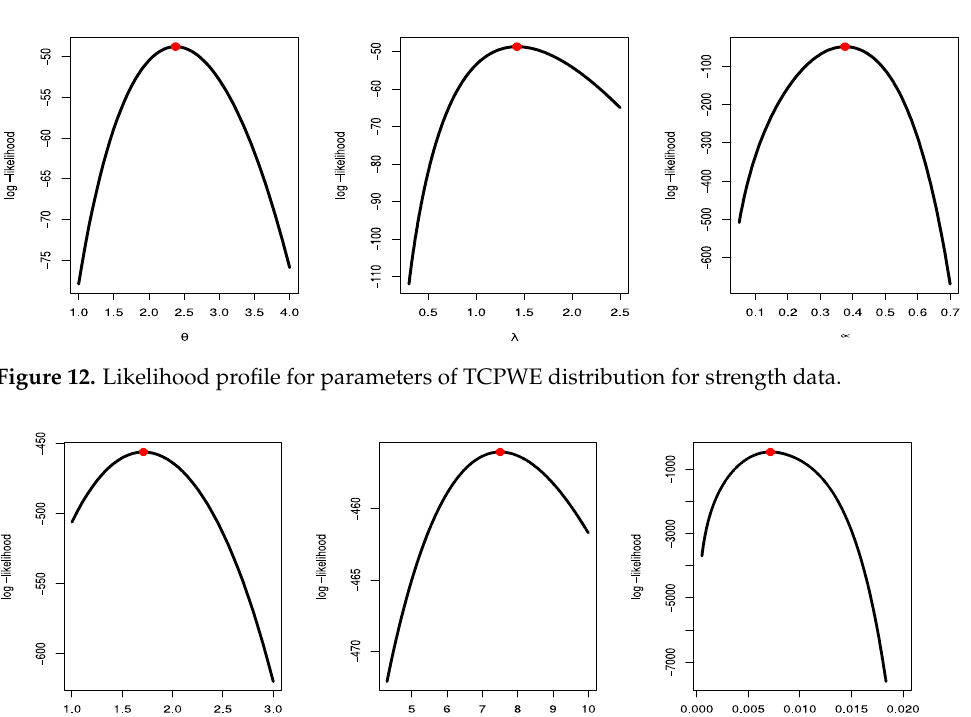
Figure 14. Likelihood profile for parameters of TCPWE distribution for COVID-19 data.